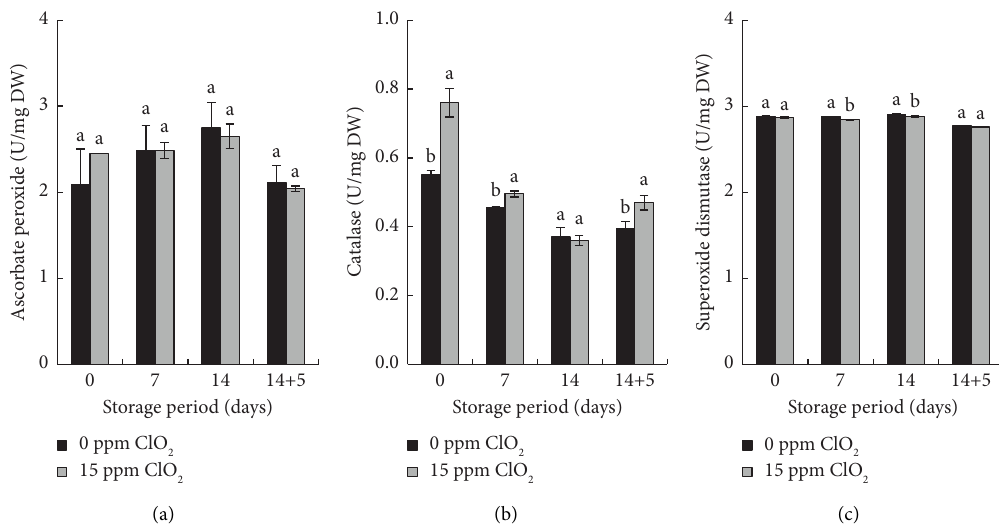
Figure 5: Efect of ClO 2 treatment on activity levels of antioxidant enzymes. (a) Ascorbate peroxidase (APX), (b) catalase (CAT), and (c) superoxide dismutase (SOD) in fruits stored at 4 ° C for 14 days followed by 5 days at 20 ° C. Data are shown as the mean ± standard error (SE) of three replicates. Diferent lowercase letters in the graph indicate statistically signifcant diferences at P < 0 .